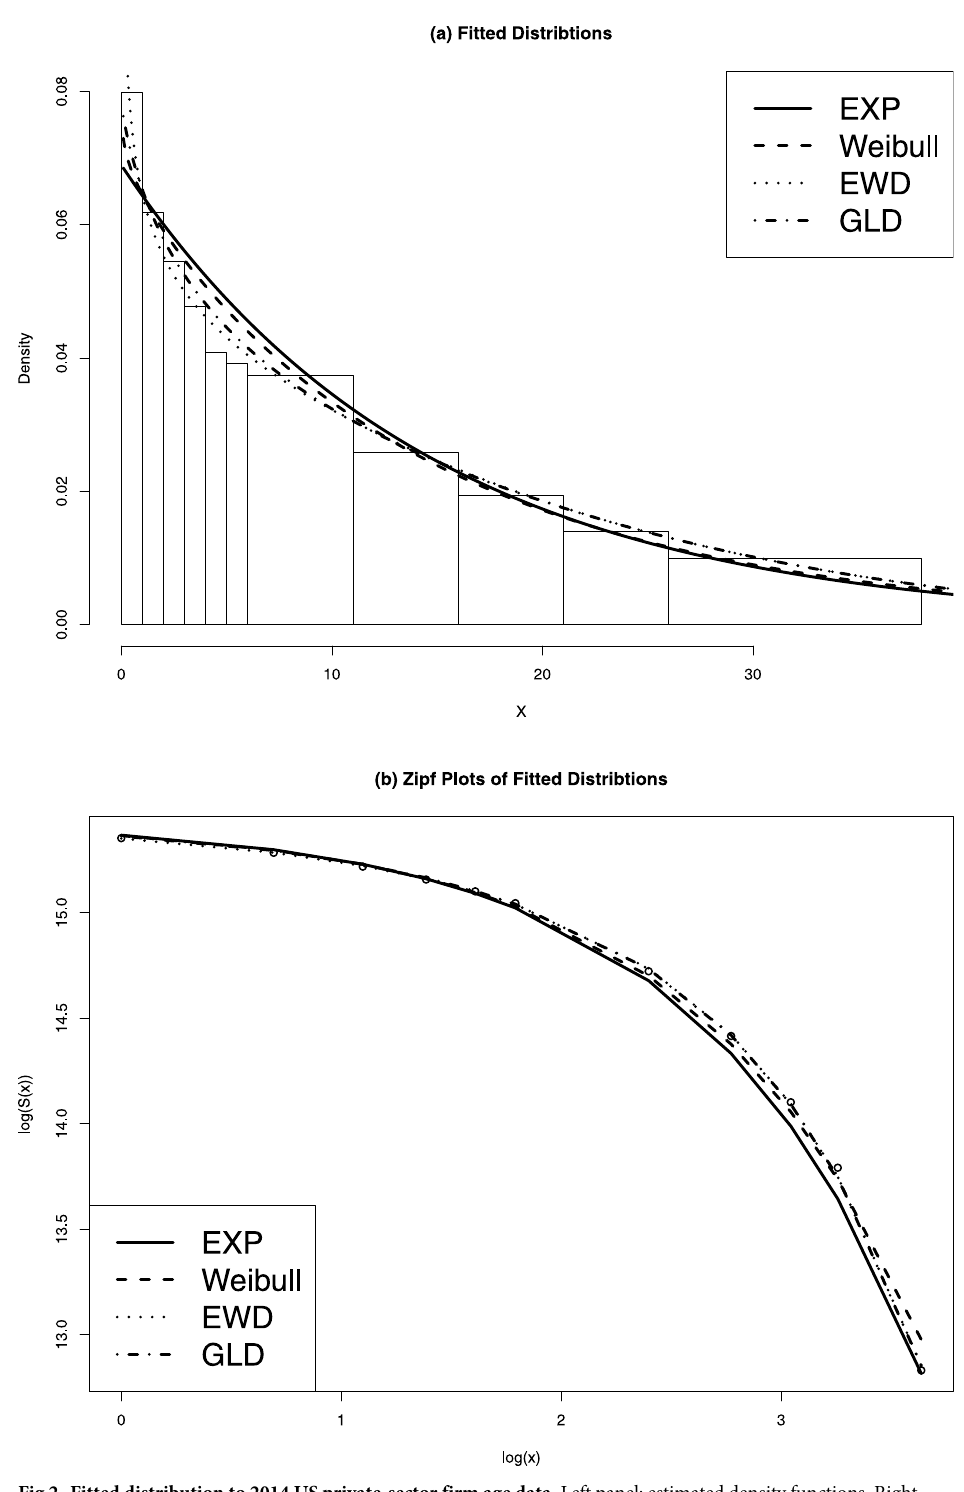
PLOS ONE | https://doi.org/10.1371/journal.pone.0235282 July 15,